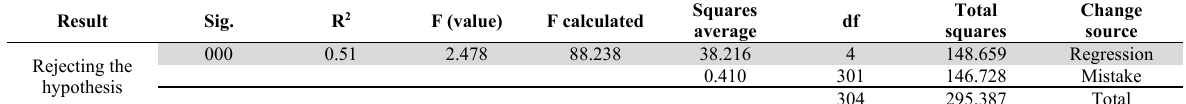
Results of the simple and multiple regression test for the effect of independent study variables on constructing trust with customers in travel & tourism organizations in Al-Kharj